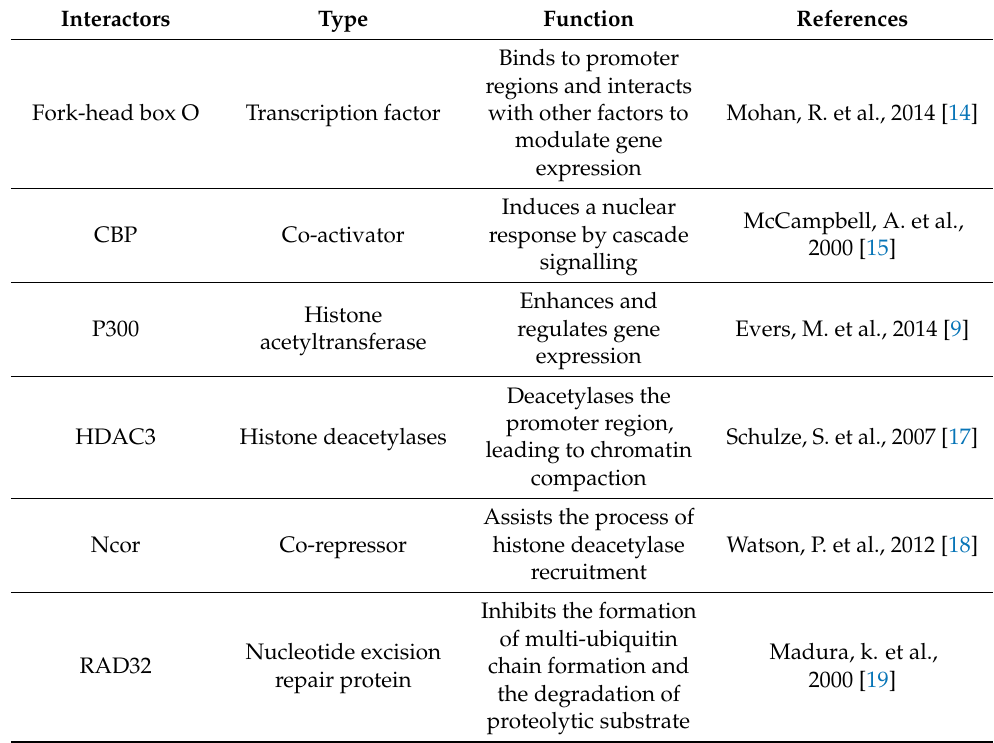
Table 1. List of several known ataxin-3 interactors and related molecular